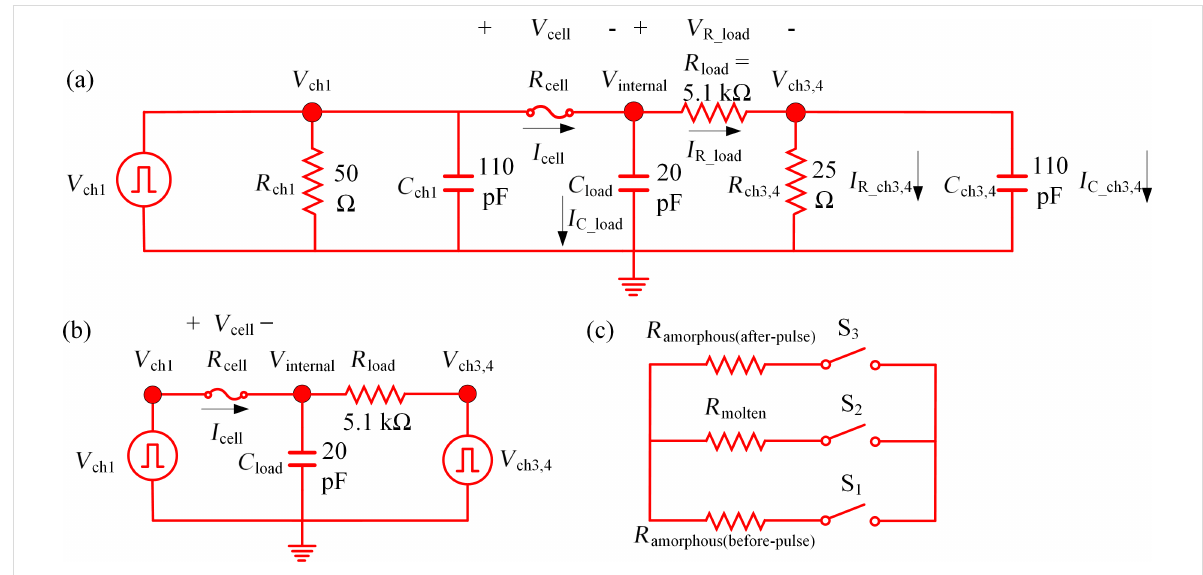
Figure 6: (a) Approximate circuit model of an experimental setup with measured parasitic capacitance and resistance values. (b) Simplified circuit model simulated in SPICE with the measured V ch1 and V ch3,4 waveforms. (c) Modeling of GST resistance switching with three switches in SPICE.